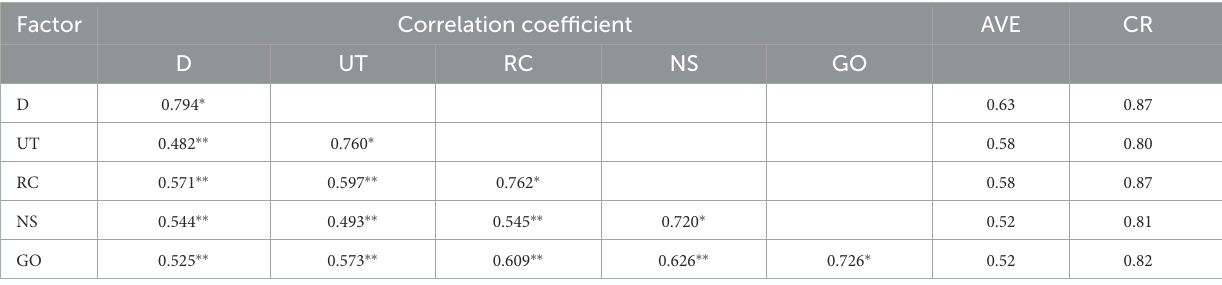
TABLE 6 Results of CFA for Chinese DoCCA scale. Factor